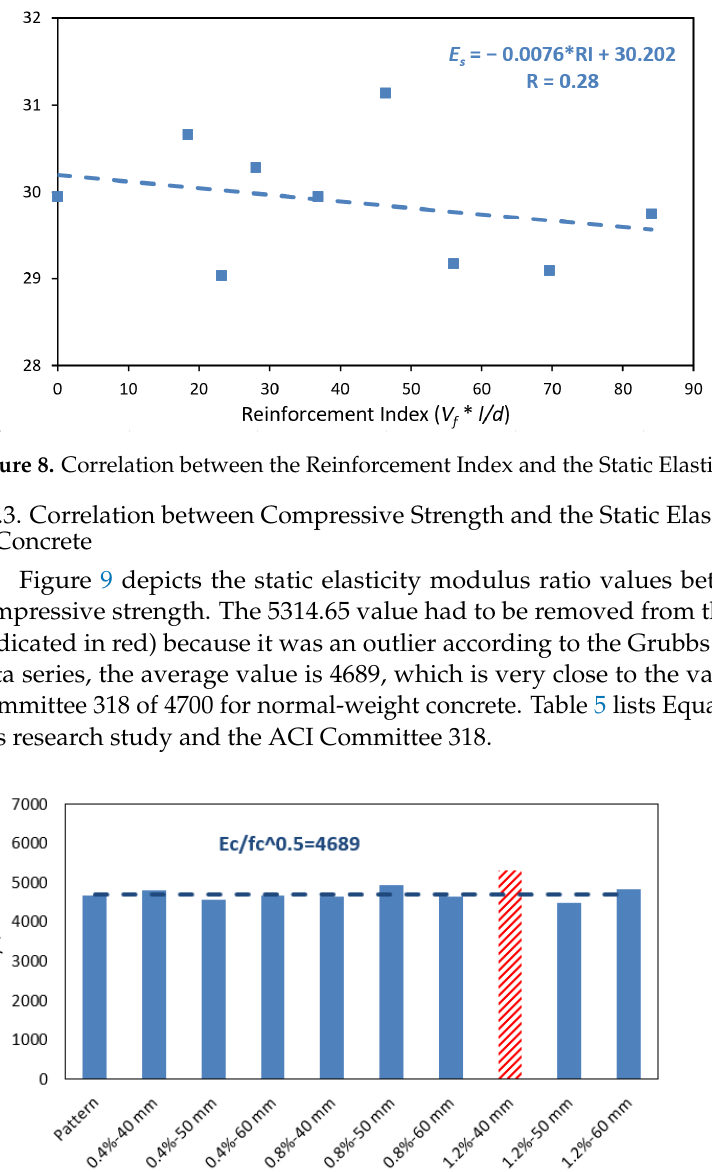
Figure 7. Correlation between the reinforcement index and compressive strength.